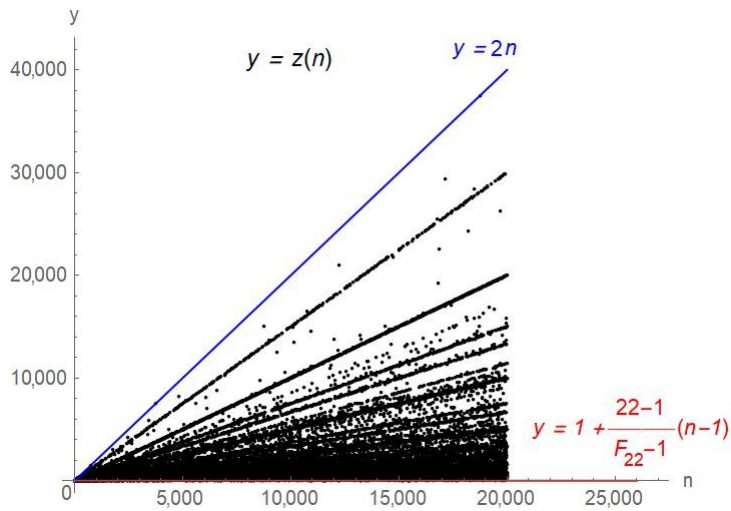
Figure 1. The graph of z ( n ) for n ∈ [1, 20,000], with the upper bounds on the blue line y = 2 n and the lower bounds on the red line y = 1 + ( 22 − 1 ) / ( F 22 − 1 )( n − 1 )